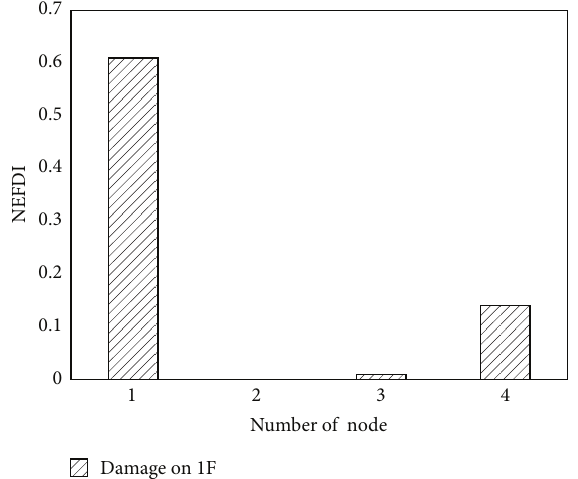
Figure 12: A damage metric chart of RMSD for damage on joint 4.